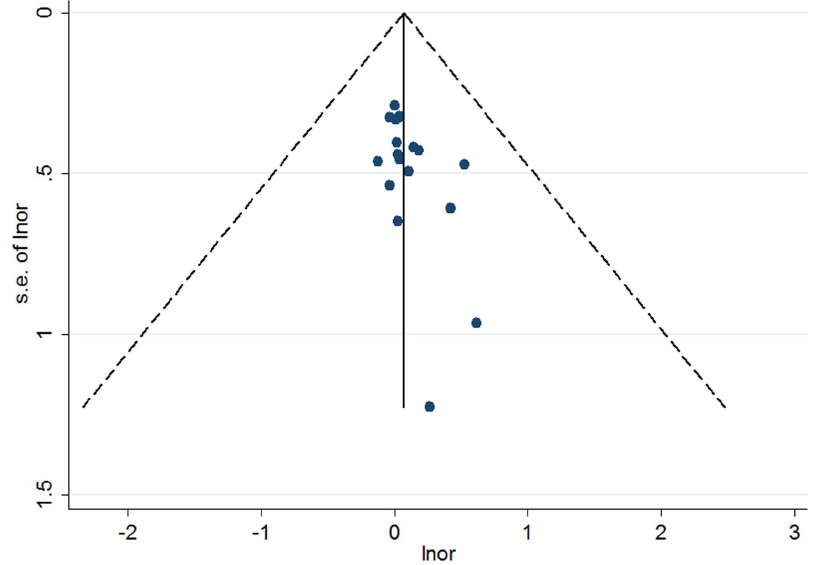
Figure 7. Funnel plot of the association between the XRCC1 Arg399Gln and breast cancer risk for the additive model.